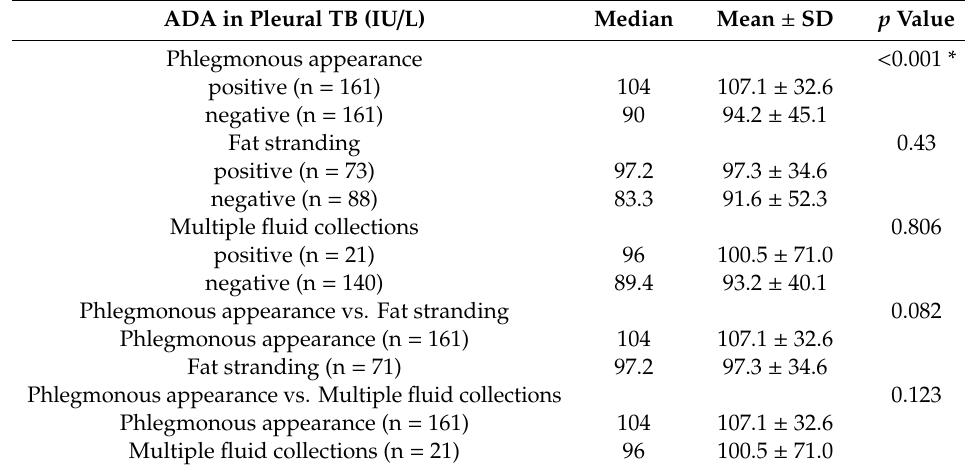
Table 4. Association between level of pleural adenosine deaminase and paracardiac CT findings in patients with pleural TB.